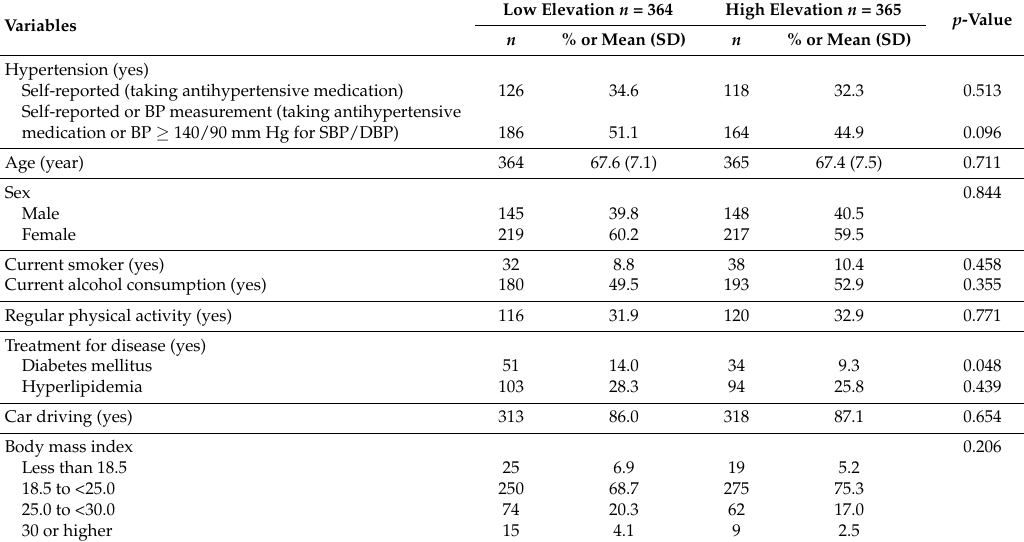
Table 1. Characteristics of the study